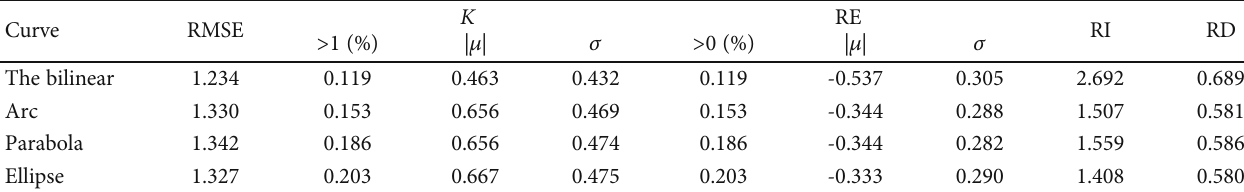
Table 2: Results of the RMSE, K , RE, RI, and RD (data from the present paper, China).